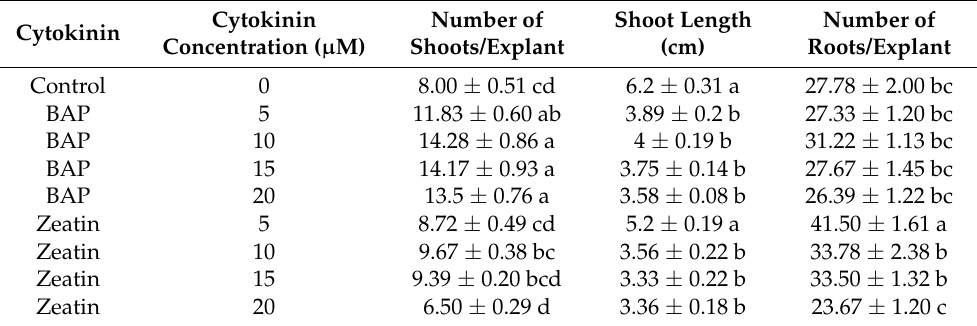
Table 2. Effects of different types and concentrations of cytokinins on shoot multiplication and rooting of Bentong ginger cultured on MS medium supplemented with 80 g L − 1 sucrose and 2.5 µ M NAA after 14 weeks of